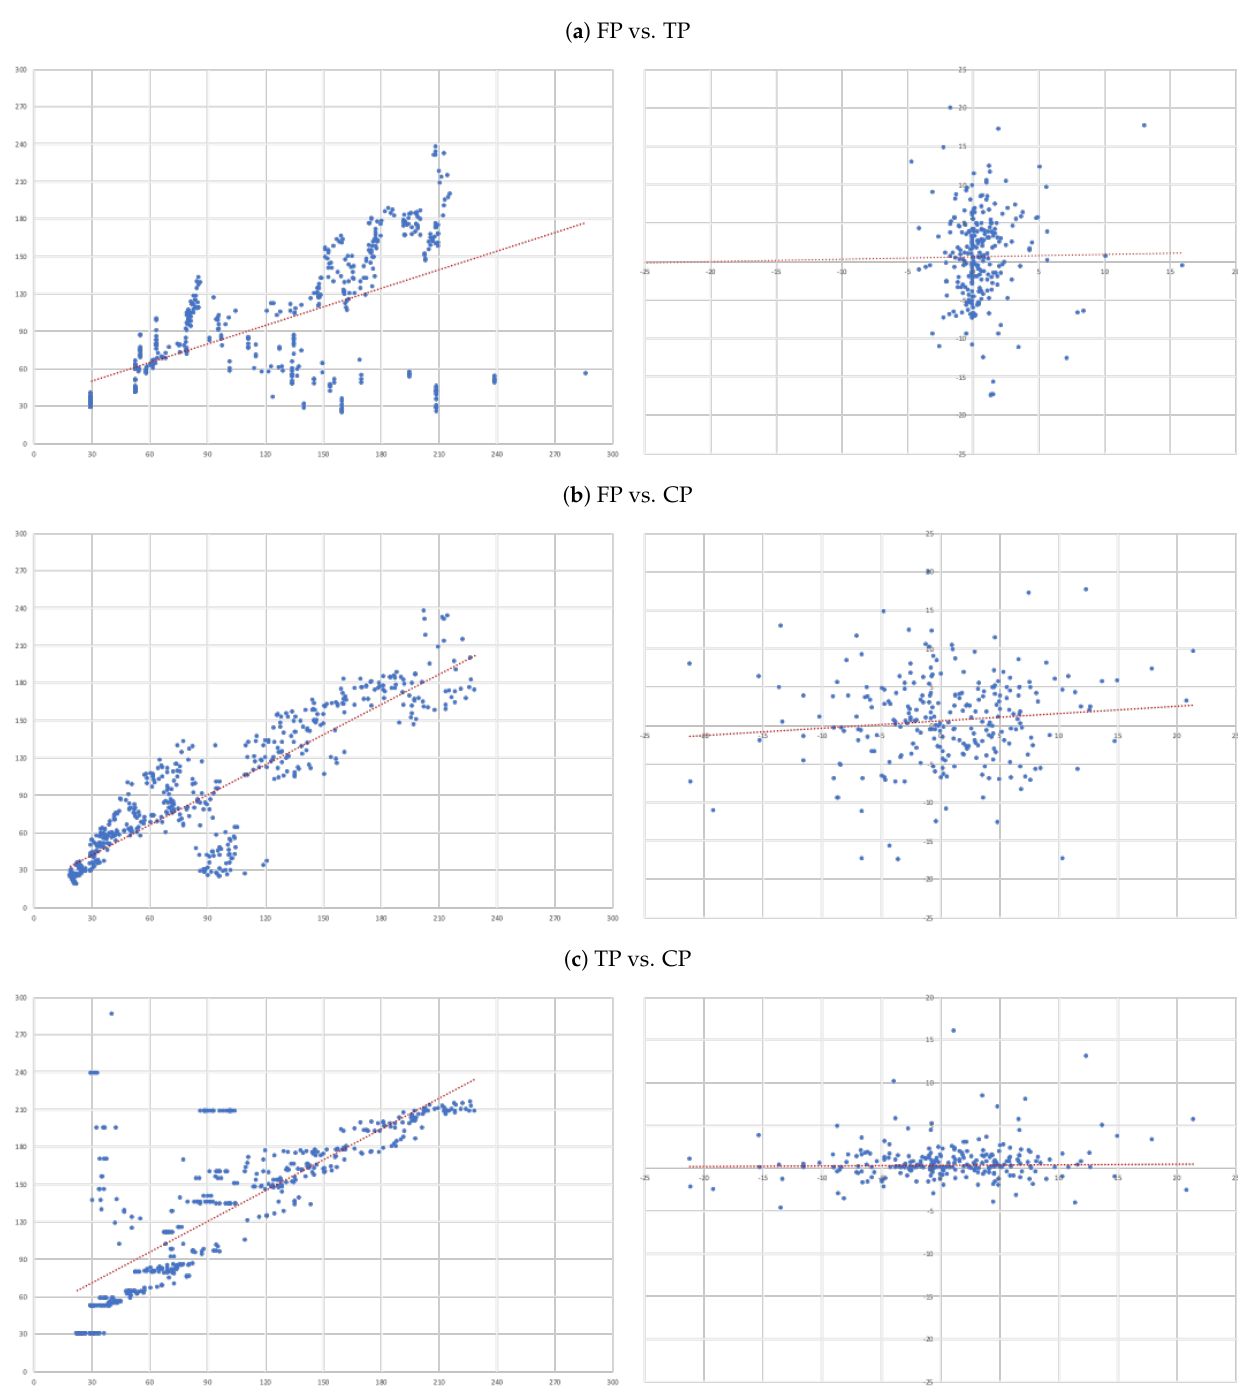
Figure A8. Volkswagen. Individual time series regressions using three price series on Volkswagen: future prices (FP), target prices (TP), and capitalised prices (CP) forecasts. On the left-hand-side are images of level regressions and on the right-hand-side are regressions in